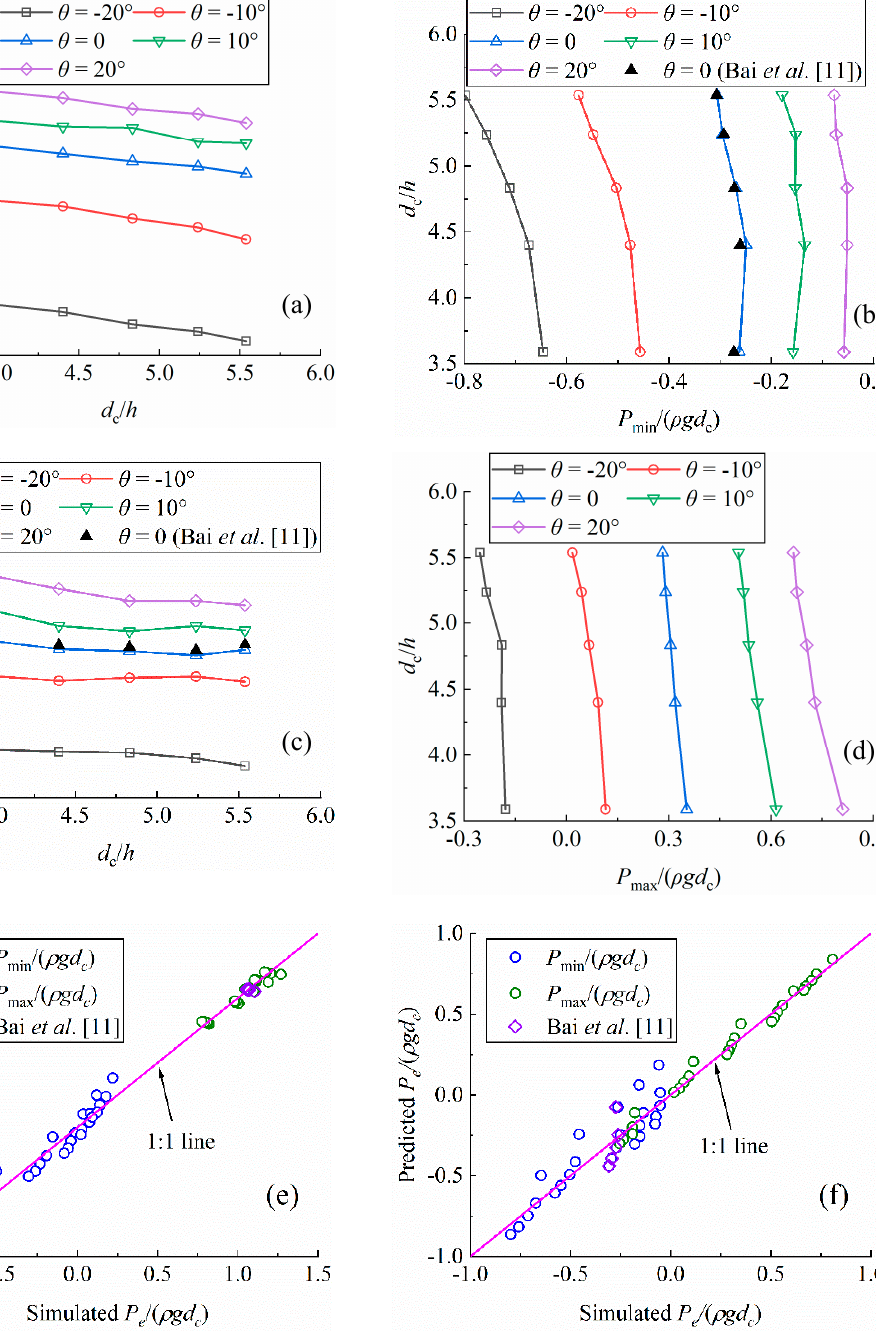
Figure 7. Extreme pressures acting on step surfaces at step no. 43: ( a , c , e ) horizontal face, and ( b , d , f ) vertical face.